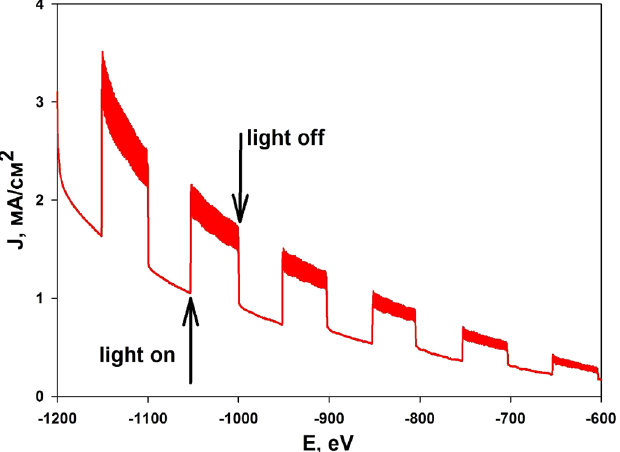
Fig. 5. The current – voltage characteristics of CZTS fi lm (at Cu/ (Zn+ Sn) = 0.5) with periodic illumination of surface.